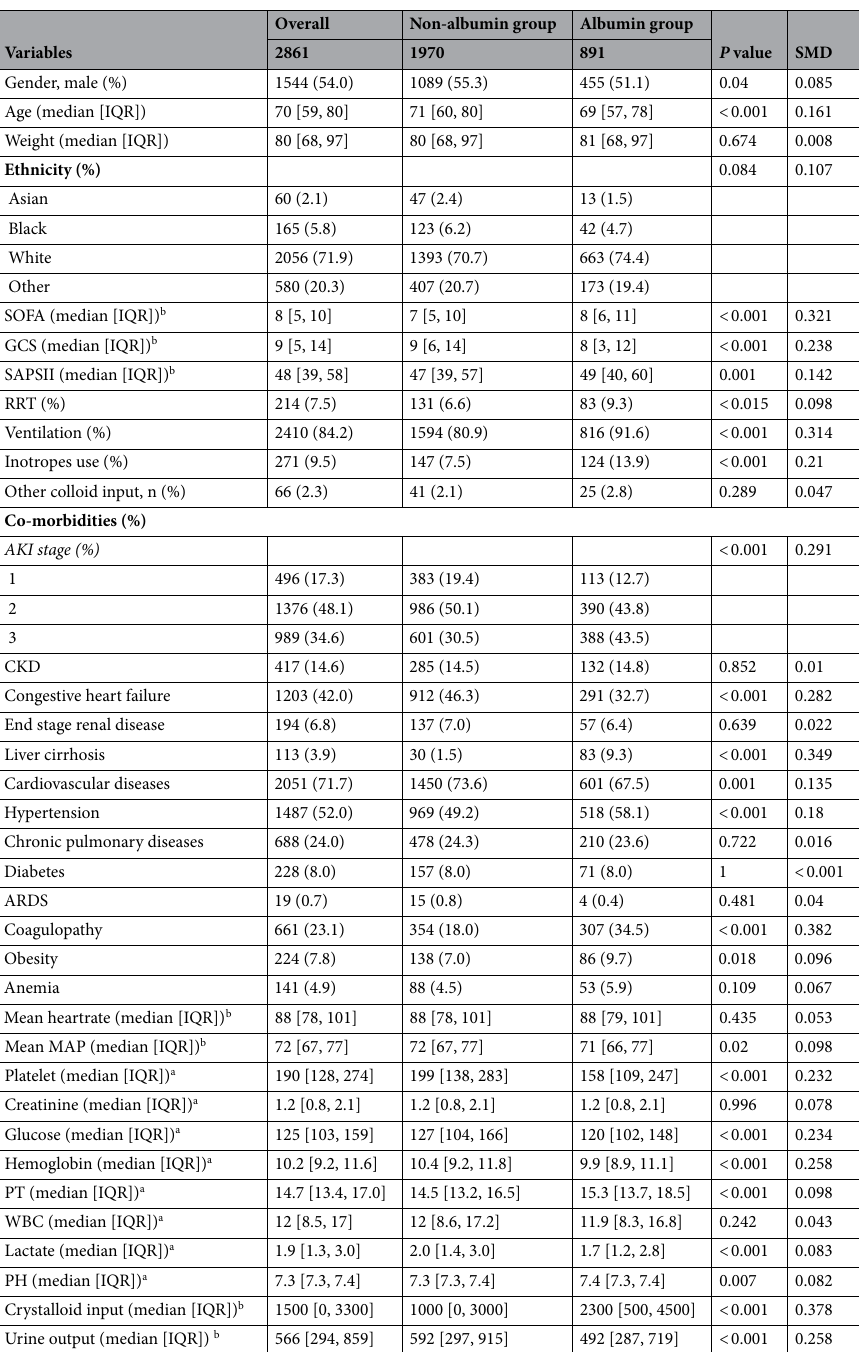
Table 1. Baseline characteristics between groups before propensity score matching. SOFA Sequential Organ Failure Assessment, SAPSII Simplified Acute Physiology Score II, GCS Glasgow Coma Scale, RRT renal replacement therapy, AKI acute kidney injury, CKD chronic kidney disease, ARDS acute respiratory distress syndrome, MAP mean arterial pressure, PT prothrombin time, WBC white blood cell, IQR interquartile range, SMD standardized mean difference. a The initial value during the first 24 h after ICU admission. b The values were calculated during the first 24 h after ICU